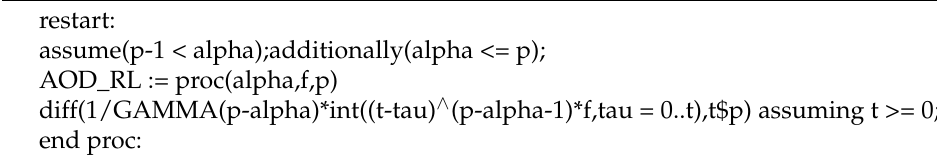
Table 2. Maple 18 code of